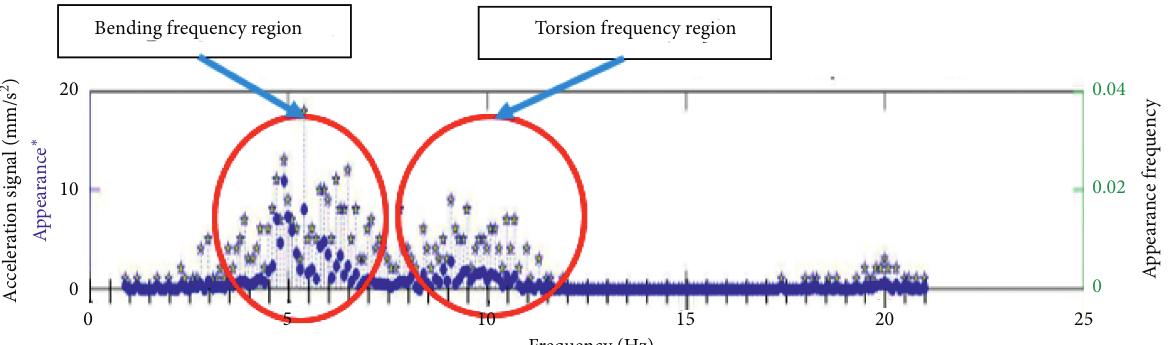
Figure 19: The representative power spectral density of Giong Ong To 2